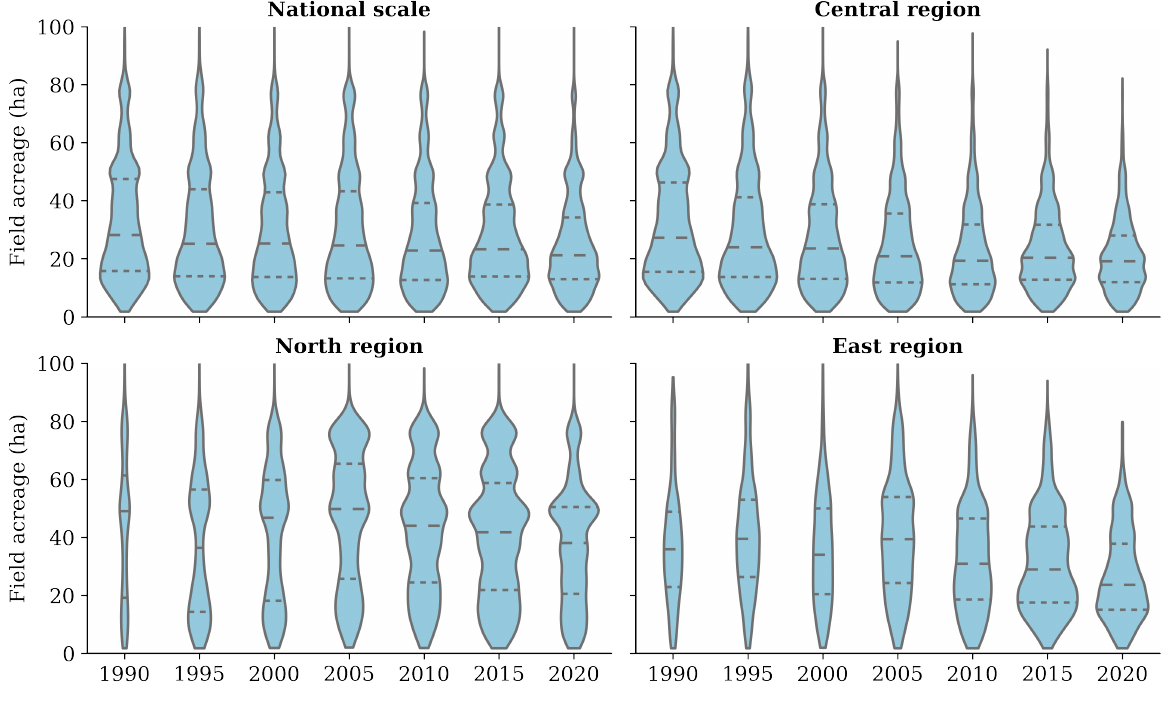
Figure 9. The change (added/removed) in total fields acreage ( left y -axis related to bars) and the number of fields ( ∆ N; right y -axis related to dashed lines) compared to the previous study year: every 5 years from 1990 to 2015 ( top panel), and every year from 2016 to 2021 ( bottom panel), at the national scale ( left ) and for each of the three regions (i.e., the central, north, and east regions as shown in Figure 1).